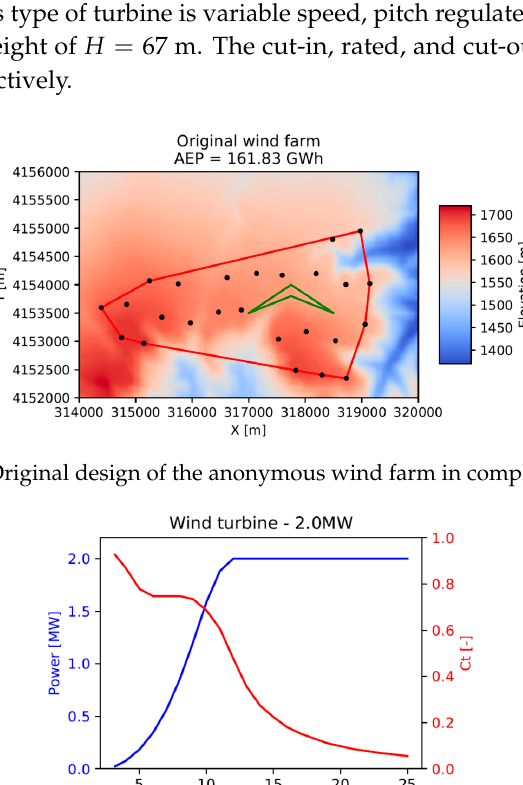
Figure 5. Architecture of the framework.